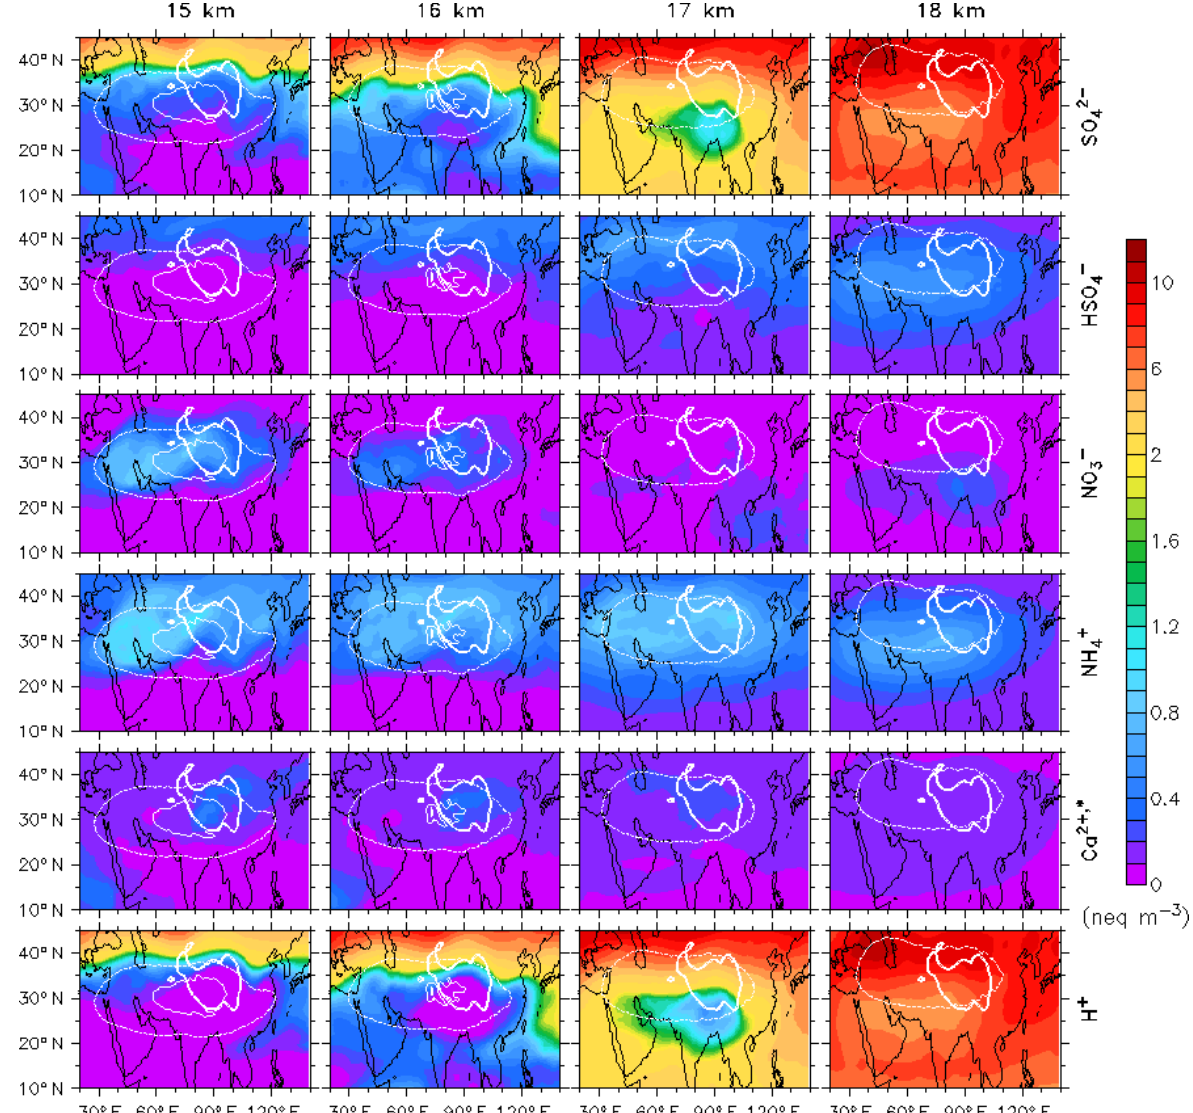
Figure 8. EMAC-simulated water-soluble ionic aerosols in the accumulation mode, including specifically SO 2 − Ca 2 + , ∗ , and H + (first to sixth rows) in units of nano-equivalent per cubic meter of air (neqm − 3 ), at altitudes of 15, 16, 17, and 18kma.s.l. (first to fourth columns), averaged for July–August 2011. Note that besides Ca 2 + , Na + , K + , and Mg 2 + are also accounted for in Ca 2 + , ∗ . Thin white lines indicate the anticyclone area, with the same index as used in Fig. 2, and thick white lines highlight the Tibetan Plateau